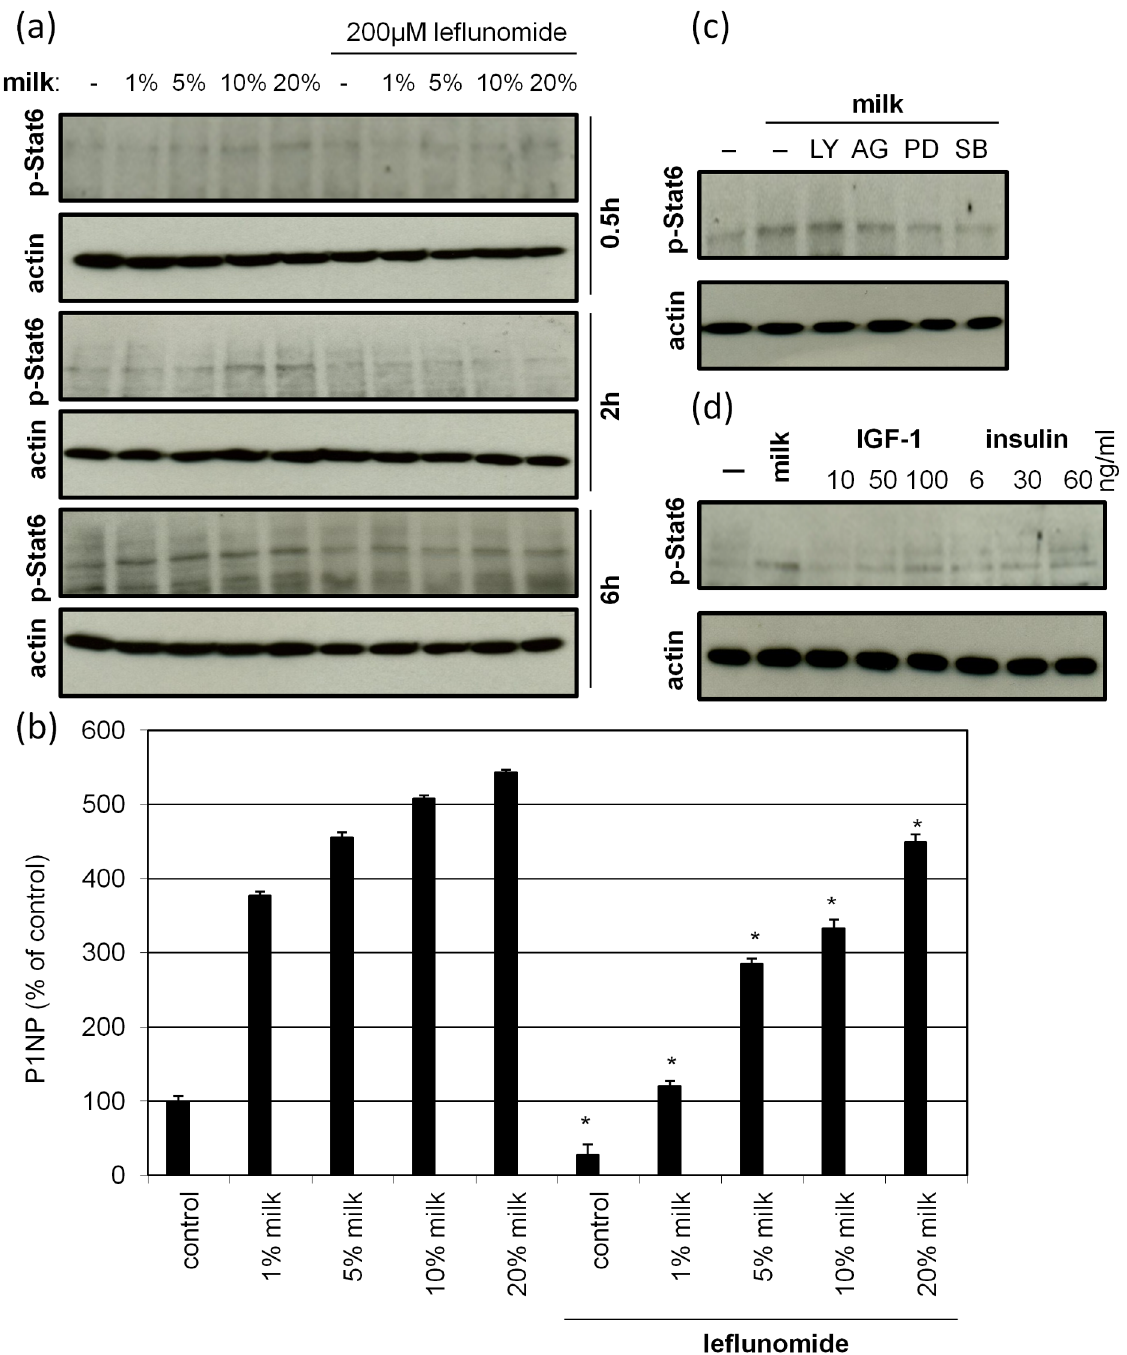
Fig 7. Bovine milk regulates collagen synthesis via STAT6. (a) Human skin fibroblasts were treated with 1, 5, 10 and 20% bovine milk with or without 200 μ M leflunomide, an inhibitor of p-STAT6. After 0,5, 2 and 6h cell lysates were examined for p-STAT6 induction by Western blot. (b) Cells were treated with 1, 5, 10 and 20% bovine milk with or without 200 μ M leflunomide. After 24 hours the amount of P1NP in the supernatants was measured. Each bar represents the mean of 3 independent experiments. Standard deviations are indicated. Data were compared to cells held under FCS-free conditions. * p < 0.05. (c) Cells were treated with 20% bovine milk in the presence of specific kinase inhibitors (20 μ M LY294002, 500 nM AG1478, 100 μ M PD98059, 20 μ M SB203580). After 6h cell lysates were examined for p-STAT6 induction. (d) Cells were treated with either 20% bovine milk or with increasing concentrations of IGF-1 or insulin. After 6h cell lysates were examined for p-STAT6 induction. Equal loading was monitored by using antibodies directed against actin. The blots show representative results. (n = 3).